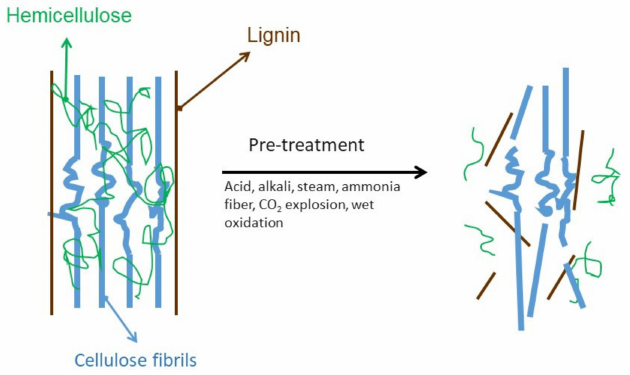
Figure 8. Biomass structure before and after